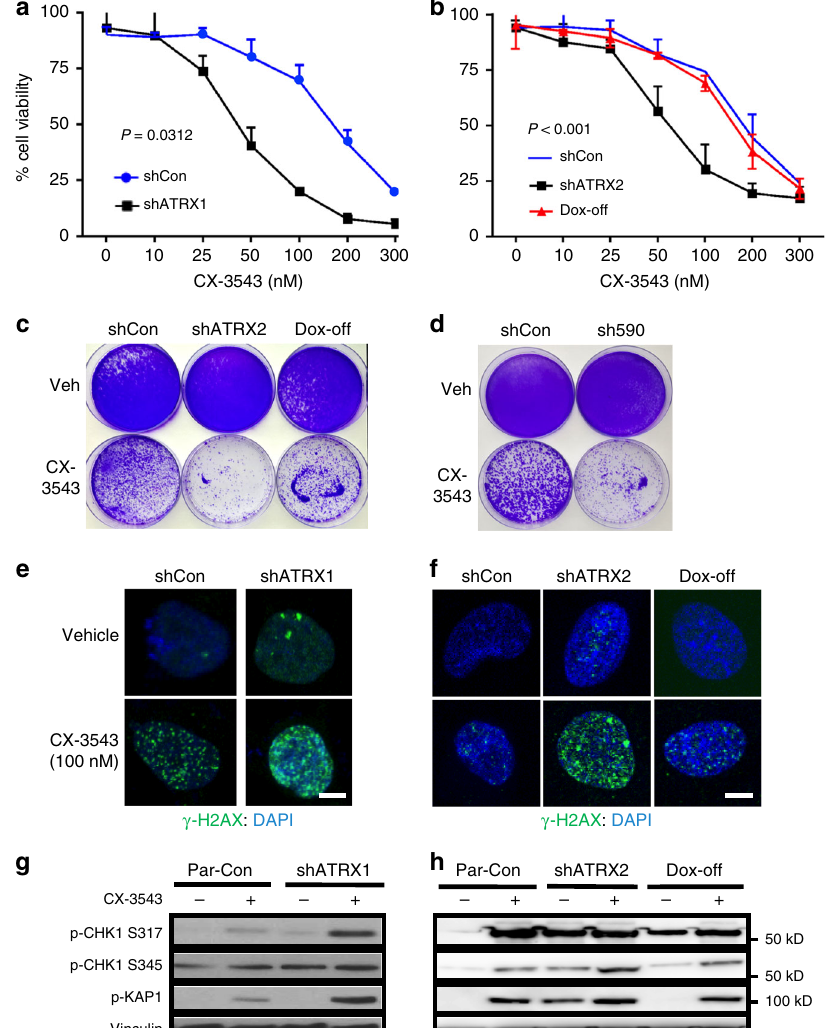
Fig. 5 ATRX-de fi cient glioma models are selectively sensitive to G4 stabilization. a , b Cell viability (CellTiter-Glo) of constitutive ( a ) and inducible ( b ) shCon and shATRX NHAs (four replicates each) treated with CX-3543 from 0-300nM. c Clonogenic assay of inducible shATRX2 NHAs demonstrates enhanced and reversible sensitivity to CX-3543 (50 nM) with ATRX de fi ciency. d Clonogenic assay of TS 543 with (sh590) and without (shCon) ATRX knockdown demonstrates enhanced sensitivity to CX-3543 (50 nM) with ATRX de fi ciency. e , f γ -H2AX immuno fl uorescence in constitutive ( e ) and inducible ( f ) shATRX NHAs showing increased DNA damage with CX-3543 treatment (100 nM), particularly in the setting of ATRX knockdown. g , h Western blots showing increased phosphorylation of replication stress pathway constituents (CHK1 and KAP1) in constitutive ( g ) and inducible ( h ) shATRX NHAs following CX-3543 treatment (100 nM). Where applicable, error bars re fl ect SEM; P values determined by two-way ANOVA; scale